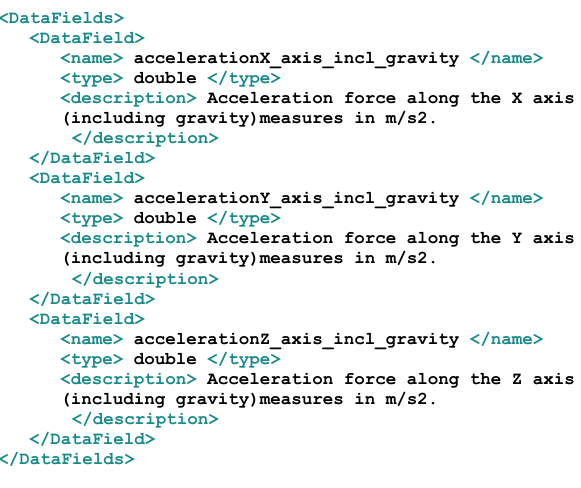
Figure 3. A Conceptual Description of MOSDEN Plugin